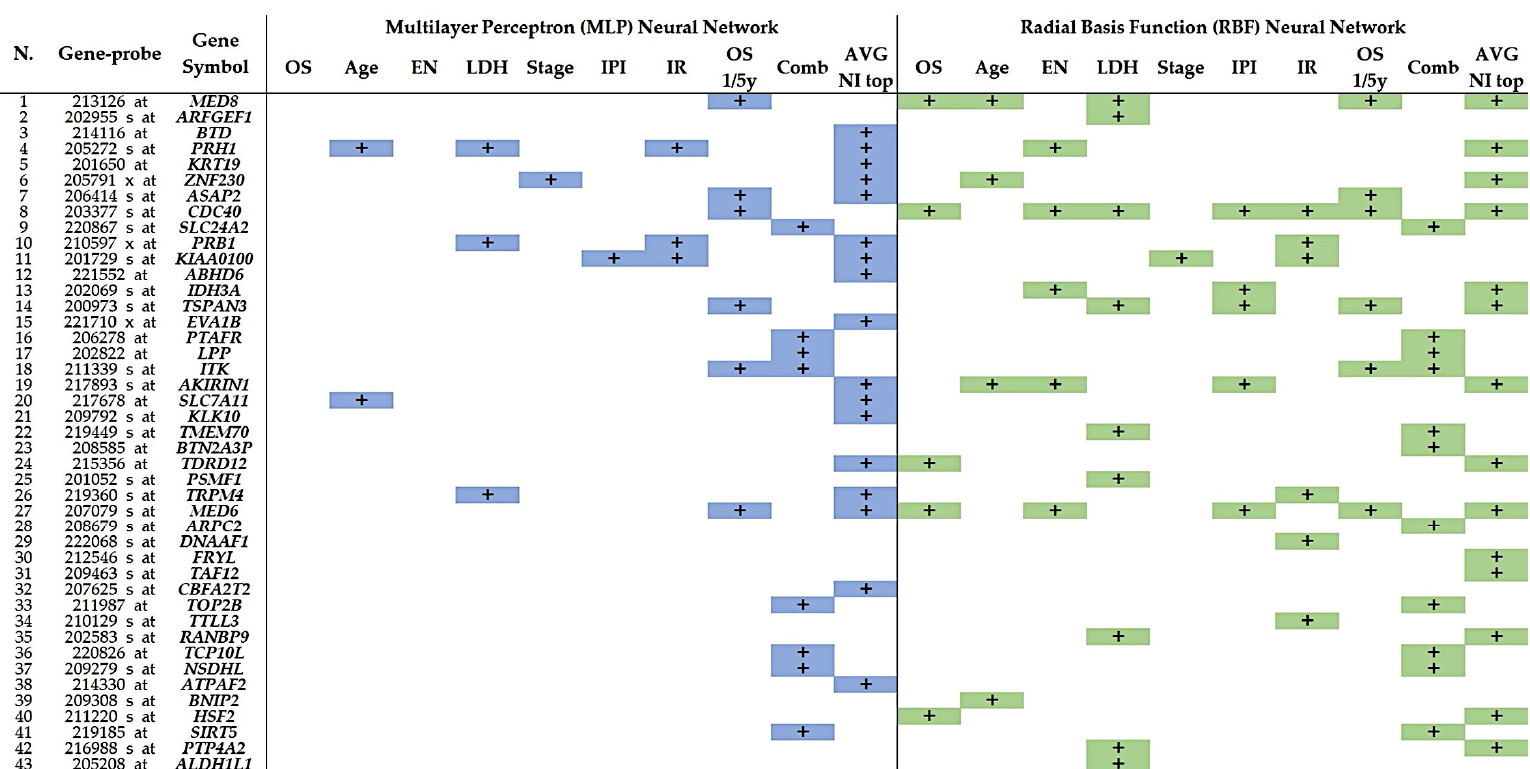
Figure 6. Contribution of each dependent variable and neural network method in the final set of 43 predictive genes. Both multilayer perceptron (MLP) and radial basis function (RBF) contribute to the final set with a synergic effect. In general, the most efficient variables are the combined and the averaged normalized importance.